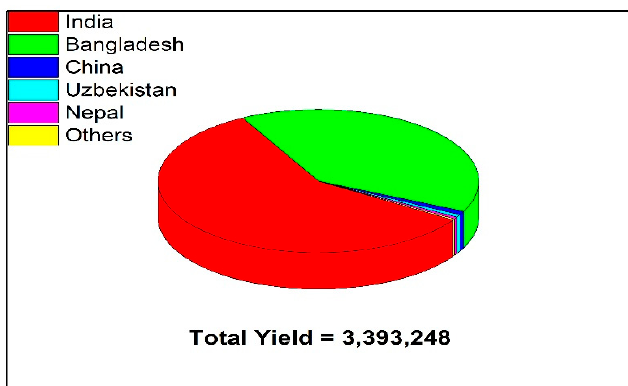
Figure 1. Some major exporters of jute fibres and their annual yields per ton .